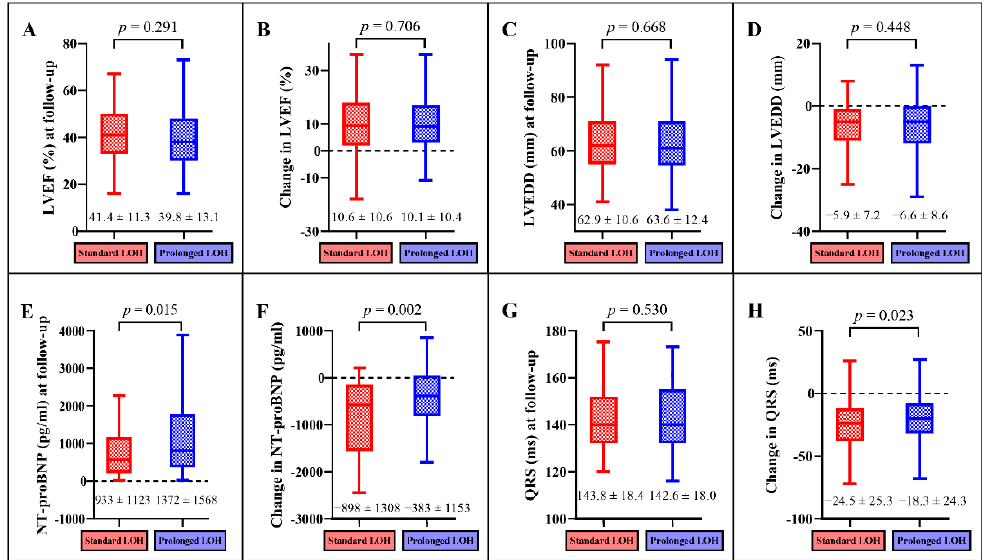
Figure 3. Comparison of cardiac function and changes in cardiac function during follow-up. Com- parison of LVEF at follow-up ( A ), change in LVEF ( B ), LVEDD at follow-up ( C ), change in LVEDD ( D ), NT-proBNP at follow-up ( E ), change in NT-proBNP ( F ), QRS at follow up ( G ), and change in QRS ( H ).